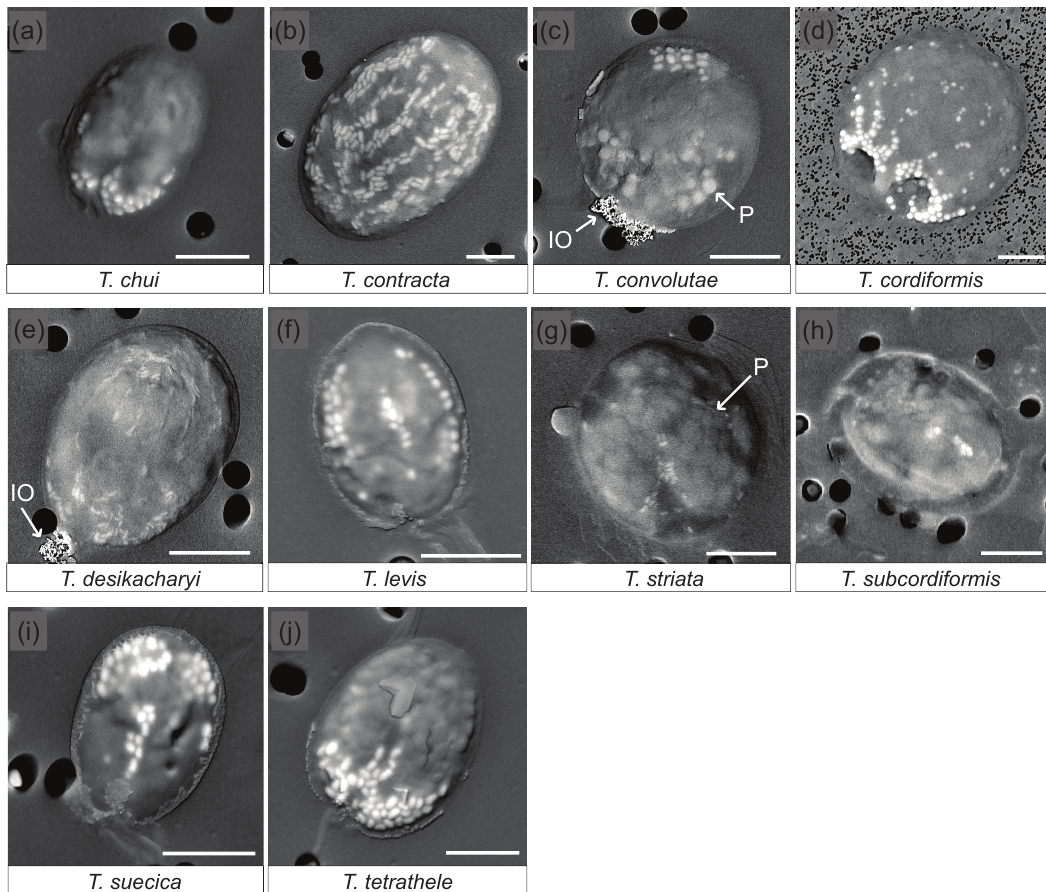
Figure 1. SEM images of 10 Tetraselmis species containing micropearls at the time of observation. Backscattered electron images of dried samples. The micropearls appear in white or light grey against the darker organic matter, as elongated shapes, except for T. cordiformis (d) , for which they are spherical. P: the larger and slightly darker inclusions are polyphosphates (c, g) . IO: iron oxides. Pores of the filters are visible as black circles in the background (2µm in diameter except for d : 0.2µm). Strains are as follows. (a) : chui_cc; (d) : cord-M_cc; (j) : tetrathele_ac. Scale bars are